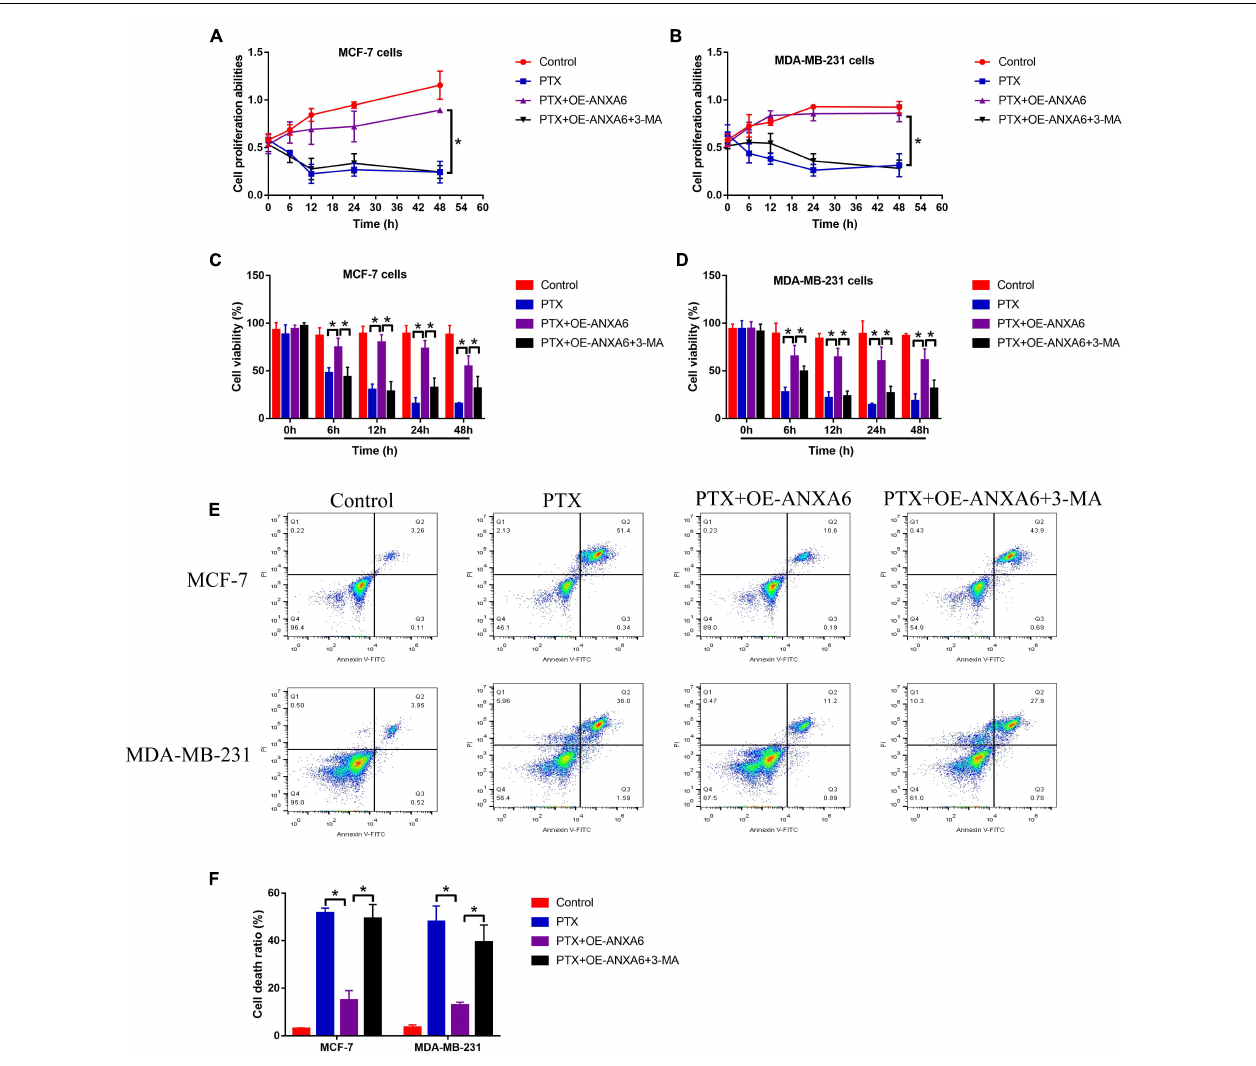
FIGURE 4 | Upregulation of ANXA6 increased PTX resistance in PS-BC cells by triggering protective autophagy. (A,B) MTT assay and (C,D) trypan blue staining assay were performed to evaluate cell proliferation and viability in PS-BC cells. (E,F) Cell death ratio was measured by using the FCM assay. A single experiment had three repetitions, and * p < 0.05 was regarded as statistical